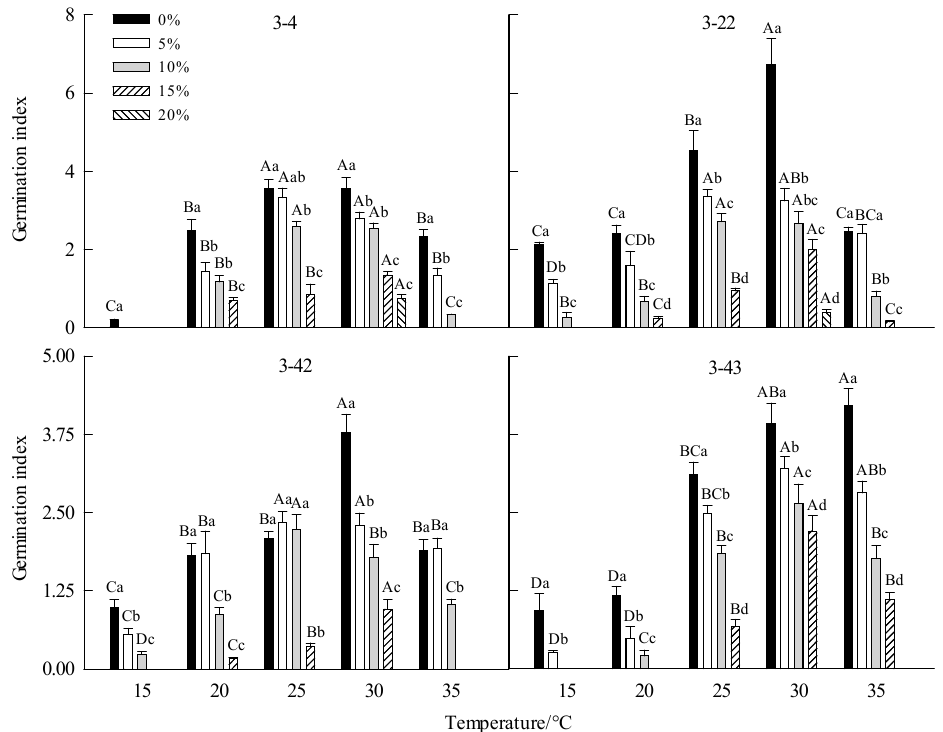
Figure 4. Effect of drought stress on seed germination index of Betula platyphylla in different families under different temperatures. Different capital letters stand for significant differences between different temperatures of the same PEG concentration ( p < 0.05), and different lowercase letters stand for significant differences between different PEG concentrations at the same temperature ( p < 0.05). 3.3. Effect of Temperature on Seeds Germination of Betula platyphylla in Different Families For 3-4 family, at 15 ℃ , the GR, GVC, and GI were the lowest. When the temperature was 25 ℃ and 30 ℃ , the GR, GVC, and GI were significantly higher than other tempera- tures, but T50 was lower than other temperatures (Table 3, Figures 1–4). For family 3-22, at 25 ℃ and 30 ℃ , the seeds GR, GVI, and GI were significantly higher than those of low temperatures (15 ℃ and 20 ℃ ) and high temperature (35 ℃ ), while T50 was significantly lower than those of low temperature (15 ℃ and 20 ℃ ) and high temperature (35 ℃ ) (Table 3, Figure 1–4). For family 3-42, at 15 ℃ , the GR GVC and GI were the lowest. At 25 ℃ and 30 ℃ , the GR was significantly higher than that at low temperature (15 ℃ and 20 ℃ ) and high temperature (35 ℃ ), while T50 was significantly higher than that at 20 ℃ and 35 ℃ (Figures 1–4). For family 3-43, at 15 ℃ and 20 ℃ , the GR did not reach 50%, at 25–35 ℃ , the seeds had high GR, GVC, and GI (Table 3, Figures 1–4). Table 3. Two-way ANOVA on the effect of temperature and drought and their interaction on seed germination in different families of Betula platyphyll. Families